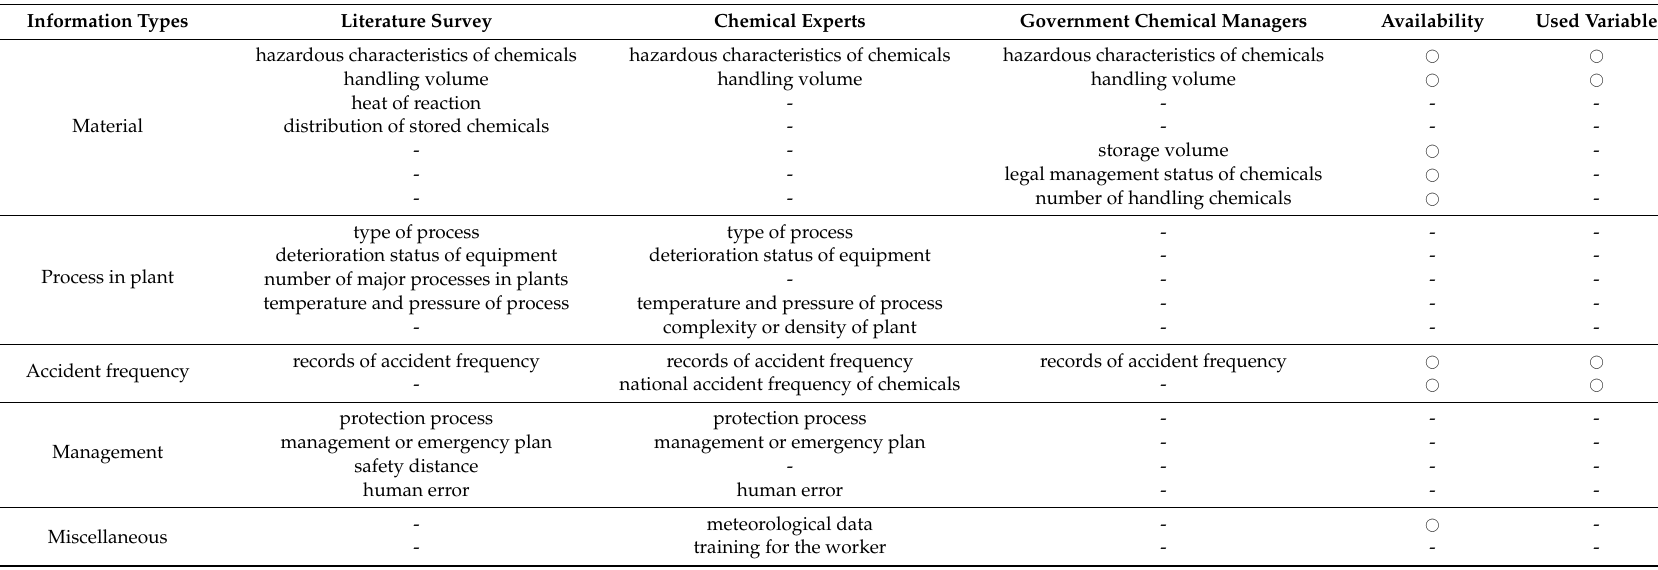
Table 1. Indicators extracted through a literature survey and interview with chemical experts and government chemical